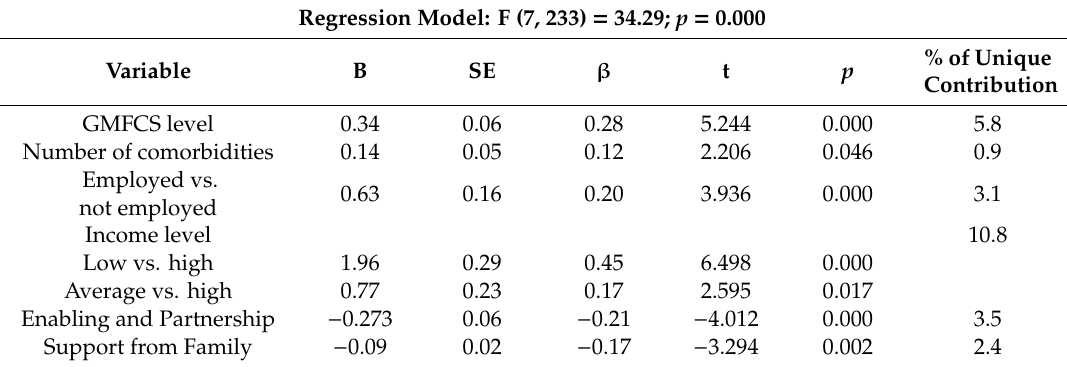
Table 14. Multiple regression model explaining financial needs for families.